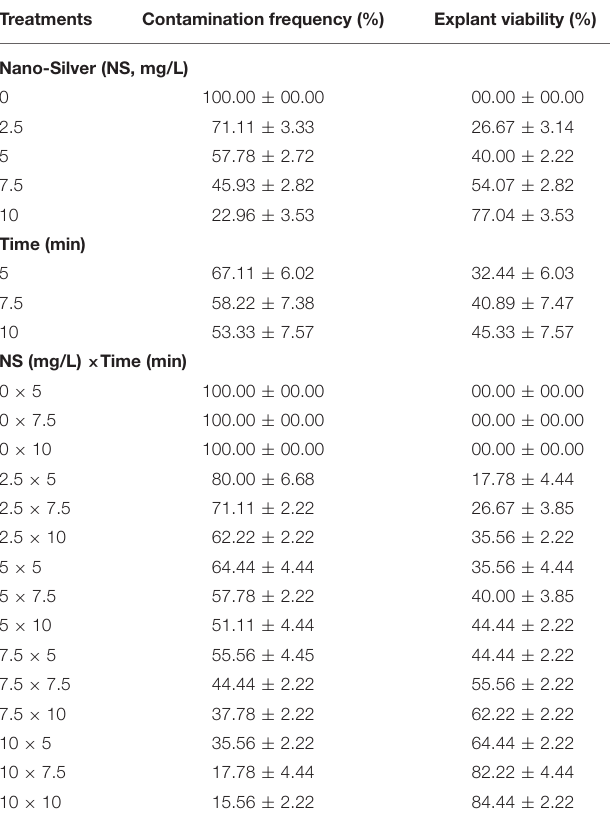
TABLE 6 | Effect of different concentrations of Nano-Silver at various immersion times on in vitro sterilization of chrysanthemum. Treatments Contamination frequency (%) Explant viability